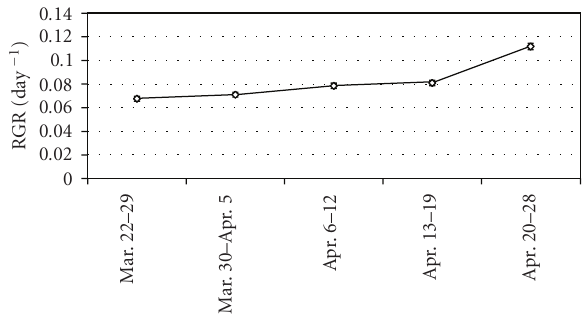
Figure 2: Increase of Azolla biomass of Milan strain, expressed as f.w. RGR (Relative Growth Rate) = (lnw 2 − lnw 1 )/( t 2 − t 1 ), calculated every seven days from Mar. 22nd to Apr. 28th 2002. Every period of which RGR is calculated, is reported on x -axis. The extreme of the date intervals is included. The bars represent the standard deviation. Fern biomass increased linearly until 19 April, followed by a more rapid growth until 28